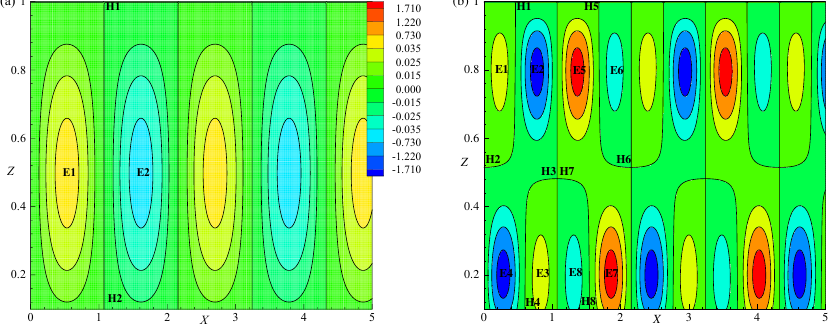
Figure 13. Vorticity lines for ( a ) R (cid:39) R co , ψ = − 0.01, Le = 0.06, χ = 0.4, t = 0.8, ( b ) R = 3 R co , ψ = − 0.01, Le = 0.06, χ = 0.4, t =